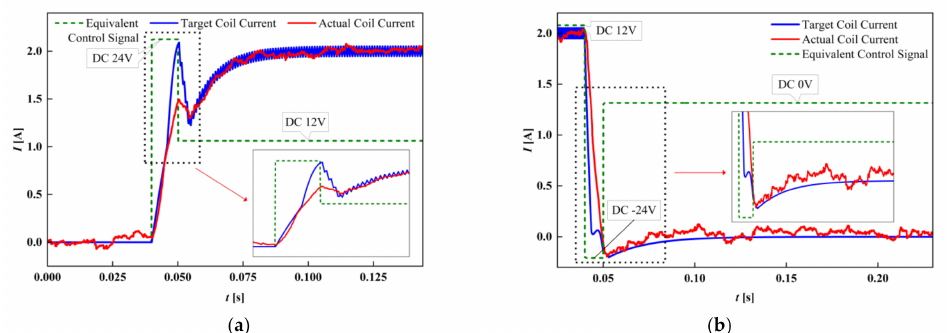
Figure 16. Correlation of the coil current between the simulated and experimental results: ( a ) valve opening dynamic characteristics; ( b ) valve closing dynamic